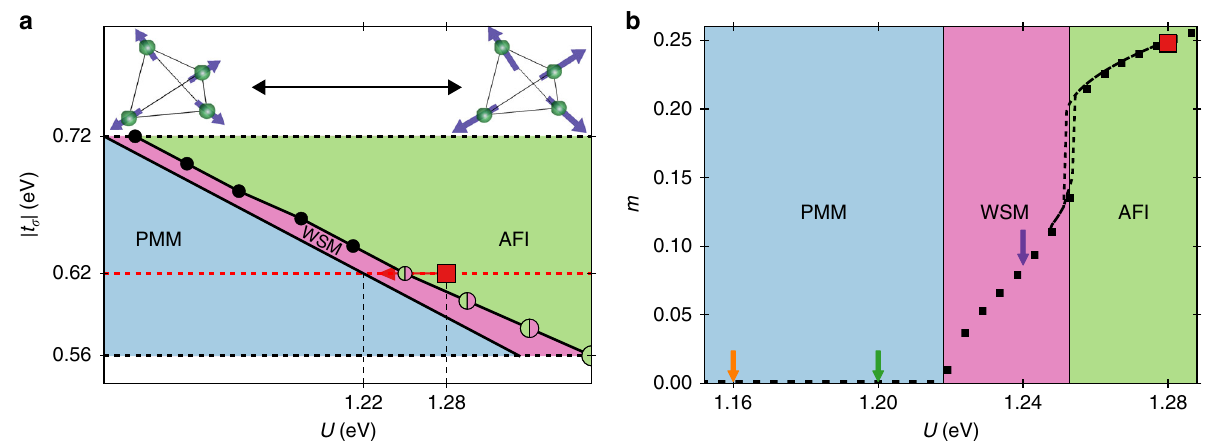
Fig. 1 Equilibrium phases. a Phase diagram as a function of Hubbard U and hopping integral, t σ , at T = 0.016 eV (186 K). The red dashed line indicates the chosen parameter subspace for our calculations at t σ = − 0.62 eV. For small interactions, U ≤ 1.22 eV, the system exhibits a paramagnetic metallic phase (PMM). In the intermediate regime, 1.22 eV < U ≤ 1.25 eV, TRS is broken by spontaneous magnetic all-in/all-out (AIAO) order. A further increase of U above 1.25 eV leads to a gapped antiferromagnetic insulating phase (AFI) with larger magnetisation. For t σ j j (cid:6) 0 : 62 eV the WSM – AFI transition is of second order, indicated by black dots. Below that value, the transition is of fi rst order (bicoloured dots). The dots ’ increasing size corresponds to the increasing region of hysteresis. The red square indicates the chosen initial state ( U i = 1.28 eV) in parameter space. The red arrow shows the intended quenching direction. b Magnetisation as a function of U for the choice of t σ = − 0.62 eV. The dashed lines indicate the region of hysteresis. The coloured arrows show the fi nal values of U = U q right after the interaction quench for the nonequilibrium calculations (see Fig.